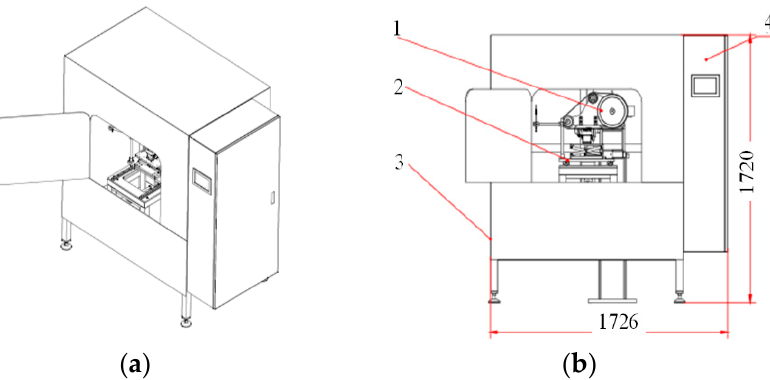
Figure 4. Schematic diagram of the appearance of the frictional wear test equipment: ( a ) axonometric projection view of the appearance of the friction tester; ( b ) a front-view projection of the appearance of the friction tester. 1—grinding mechanism; 2—table for the sample to be tested; 3—outer cover of the tester; 4—control systems for equipment.